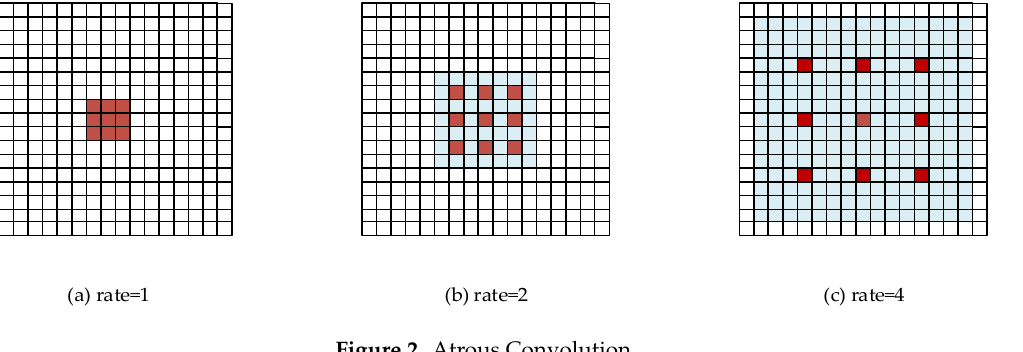
Figure 2. Atrous Convolution.